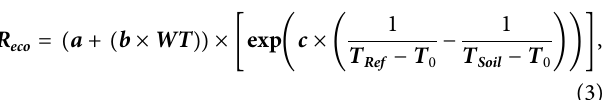
Frontiers in Earth Science |